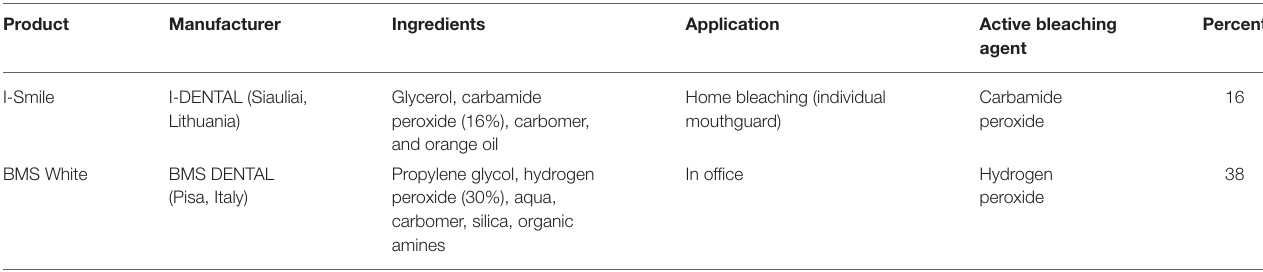
TABLE 1 | Summarized bleaching products (data given by the manufacturer) including ingredients, application, active bleaching agent, and percentage concentration of hydrogen or carbamide